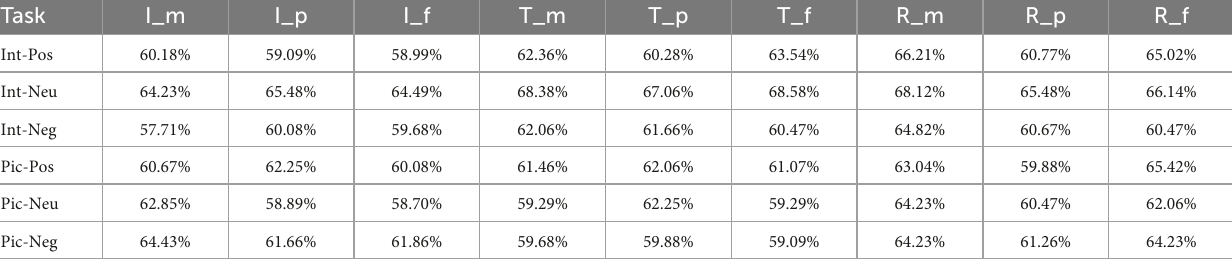
TABLE 6 Accuracy comparison of nine speaker embeddings under interview or picture description tasks with different emotions using SVM classifier.